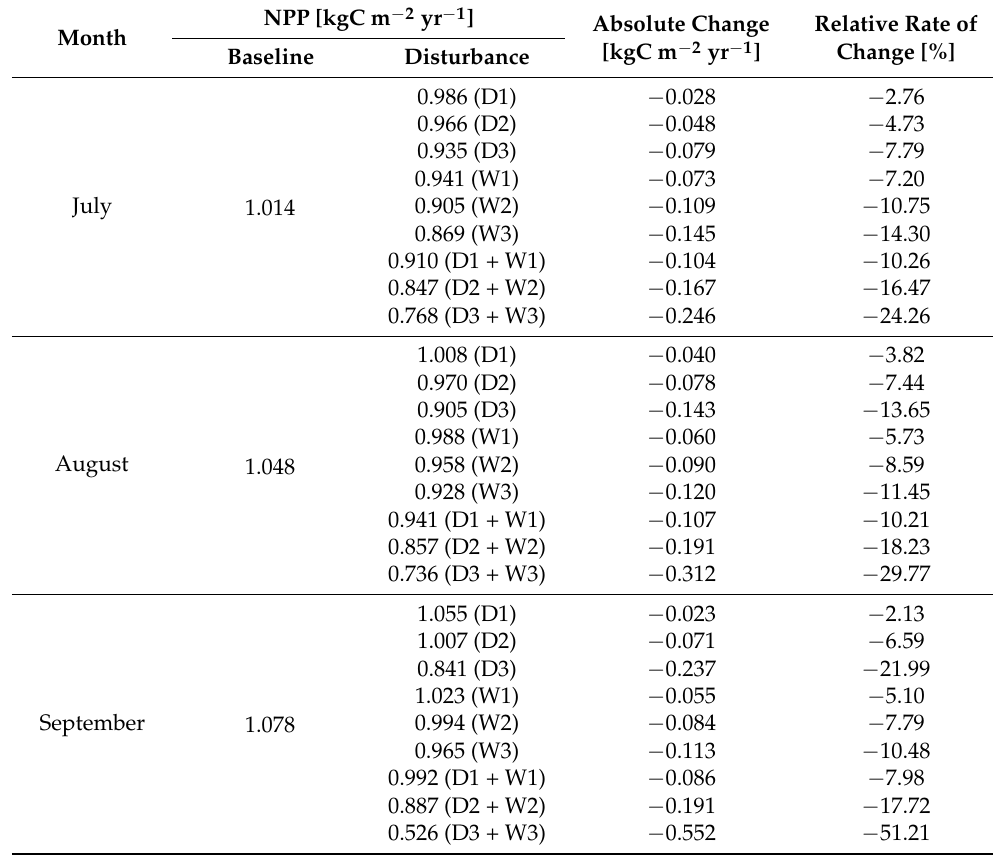
Table 5. Absolute change and relative change rate of NPP (kgC m − 2 yr − 1 ) during the drought and/or warming scenarios (July~September).